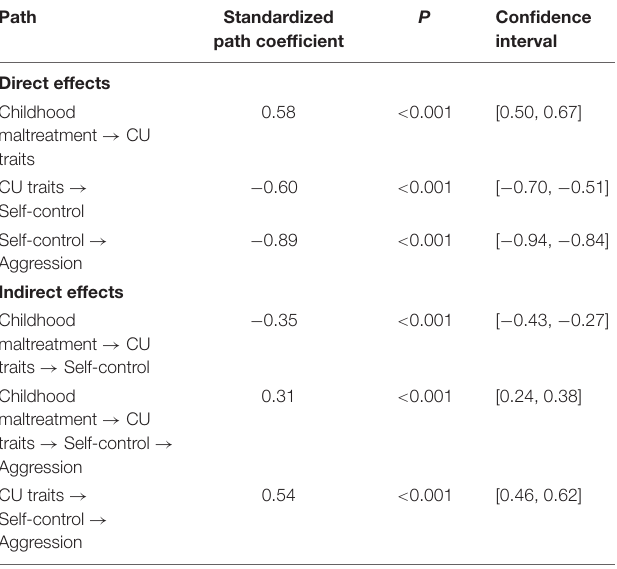
TABLE 5 | Direct and indirect effects in the sequential multiple mediation model.